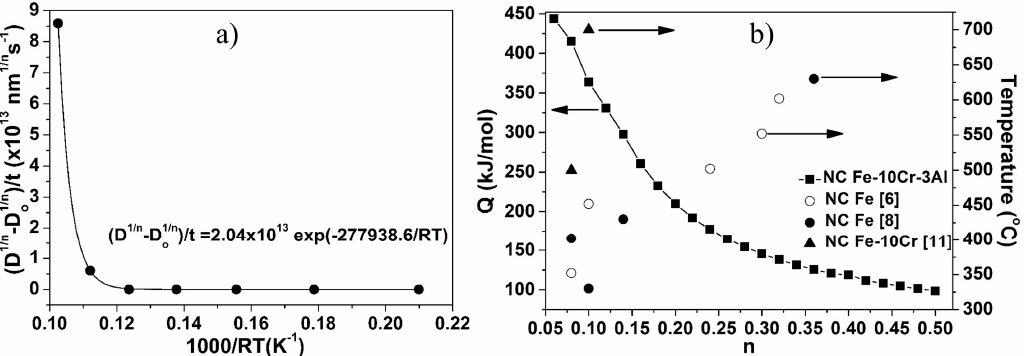
Figure 9. ( a ) Plot of Equation (4) for time exponent of 0.15 and ( b ) effect of temperature on time exponent and effect of time exponent on the activation energy for isothermal grain growth (arrows indicate the axis corresponds to that value).